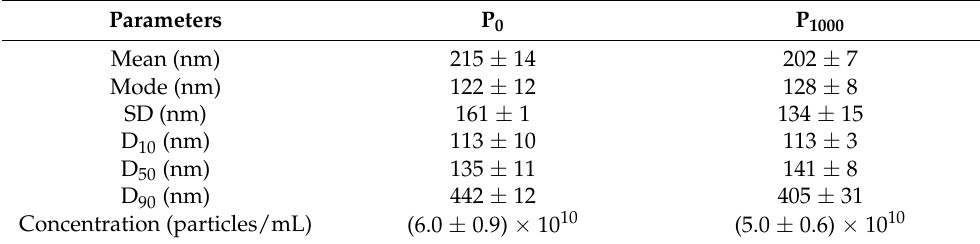
Table 6. Average particle size measured by NTA considering the P 0 and P 1000 systems. Parameters